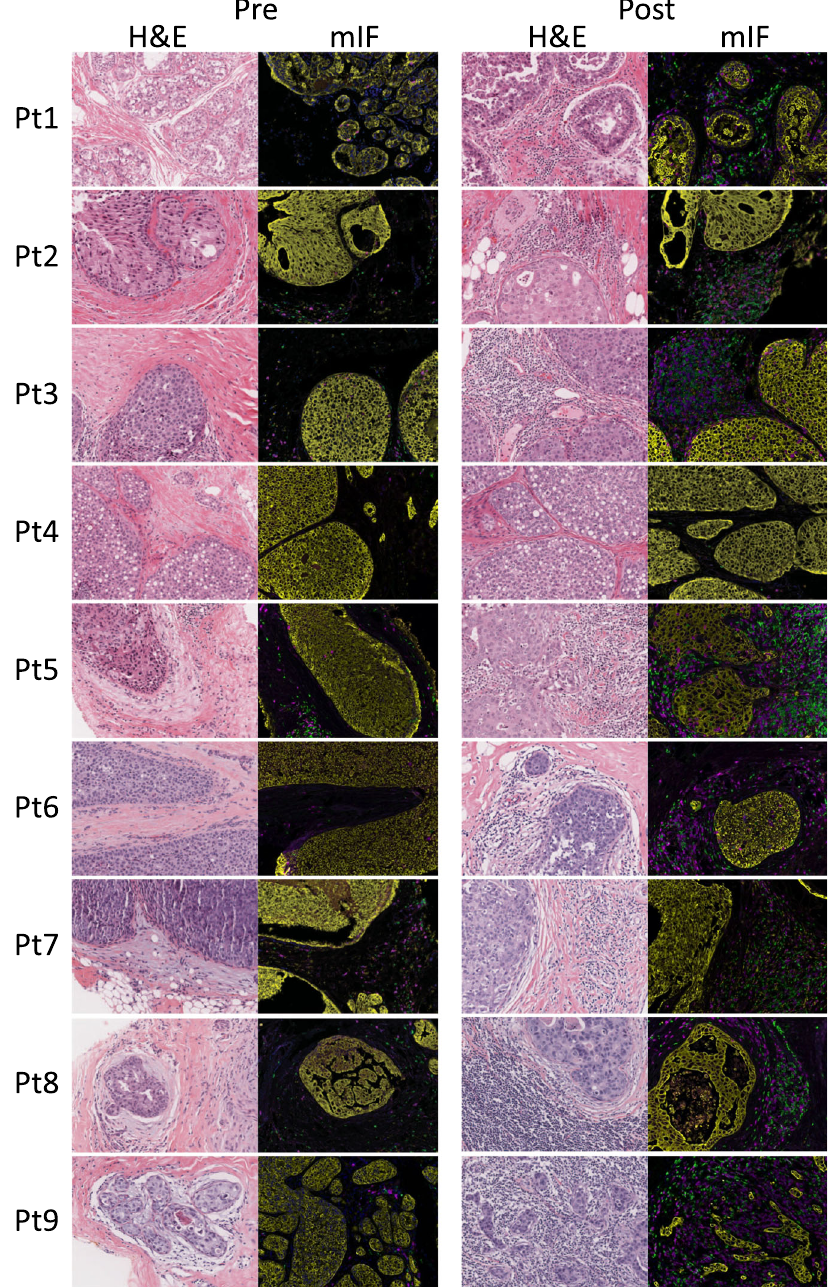
Fig. 1 T cell in fi ltrates in DCIS pre-treatment and post-treatment with intralesional anti-PD-1. Representative hematoxylin and eosin (H&E) and multiplex immuno fl uorescence (mIF) images from pre-therapy biopsies and post-therapy surgical specimens are shown for each patient. For the mIF staining, CD3-positive cells are pseudocolored green, CD8-positive cells are magenta, and cytokeratin-positive cells are yellow. Original magni fi cation: